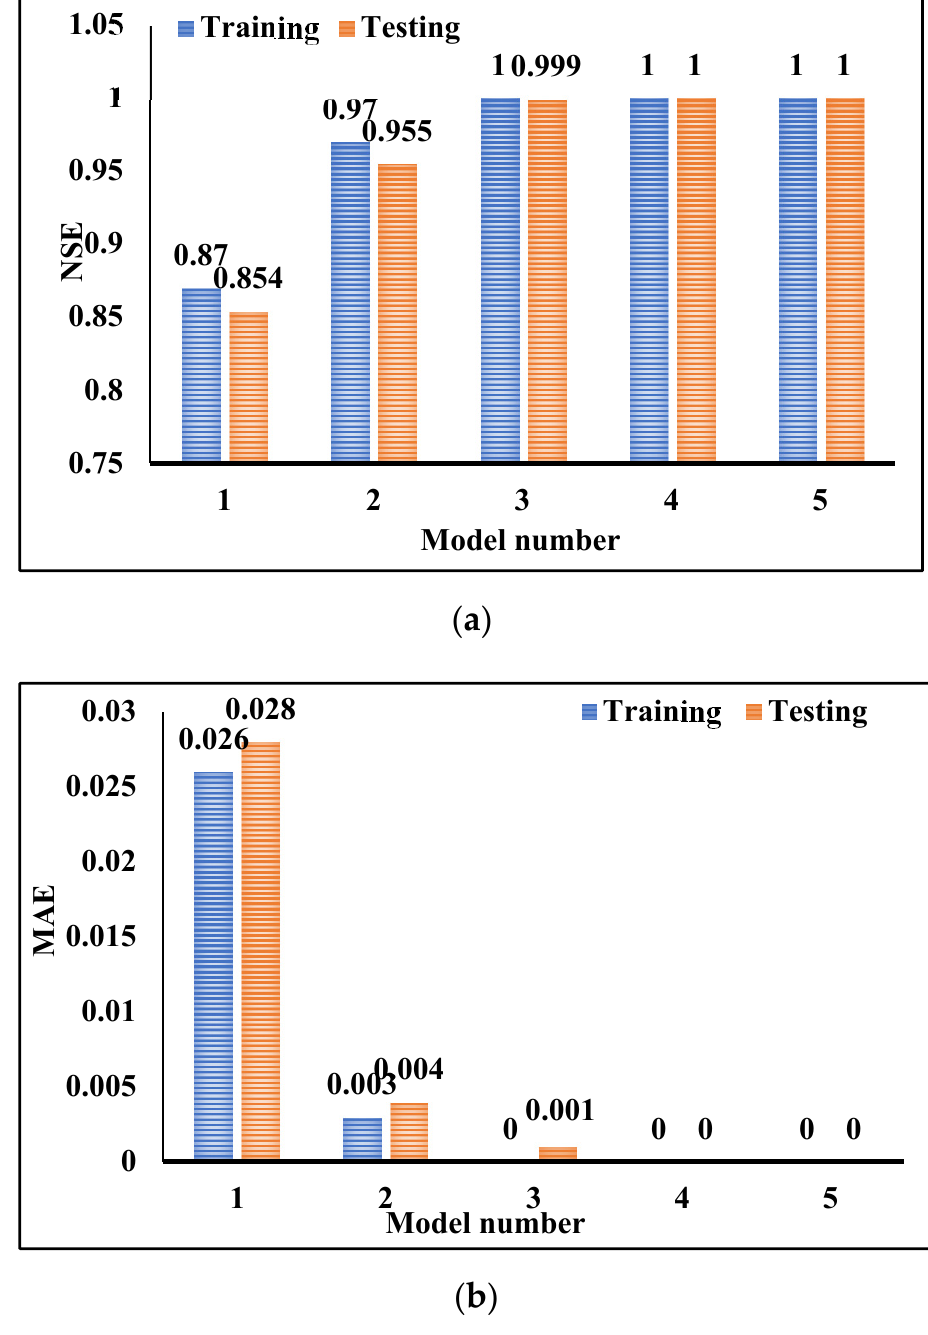
Figure 14. Evaluation values in the training and testing phases: ( a ) NSE; ( b ) MAE. Figure 15 depicts the error histogram for model 5. This figure could prove the accuracy of the model in each training and testing phase again. It was found that ANFIS had an accurate prediction since both the training and testing phases have the same pattern (convergence) in the same area of the samples, and also the difference between predicted and measured values is not